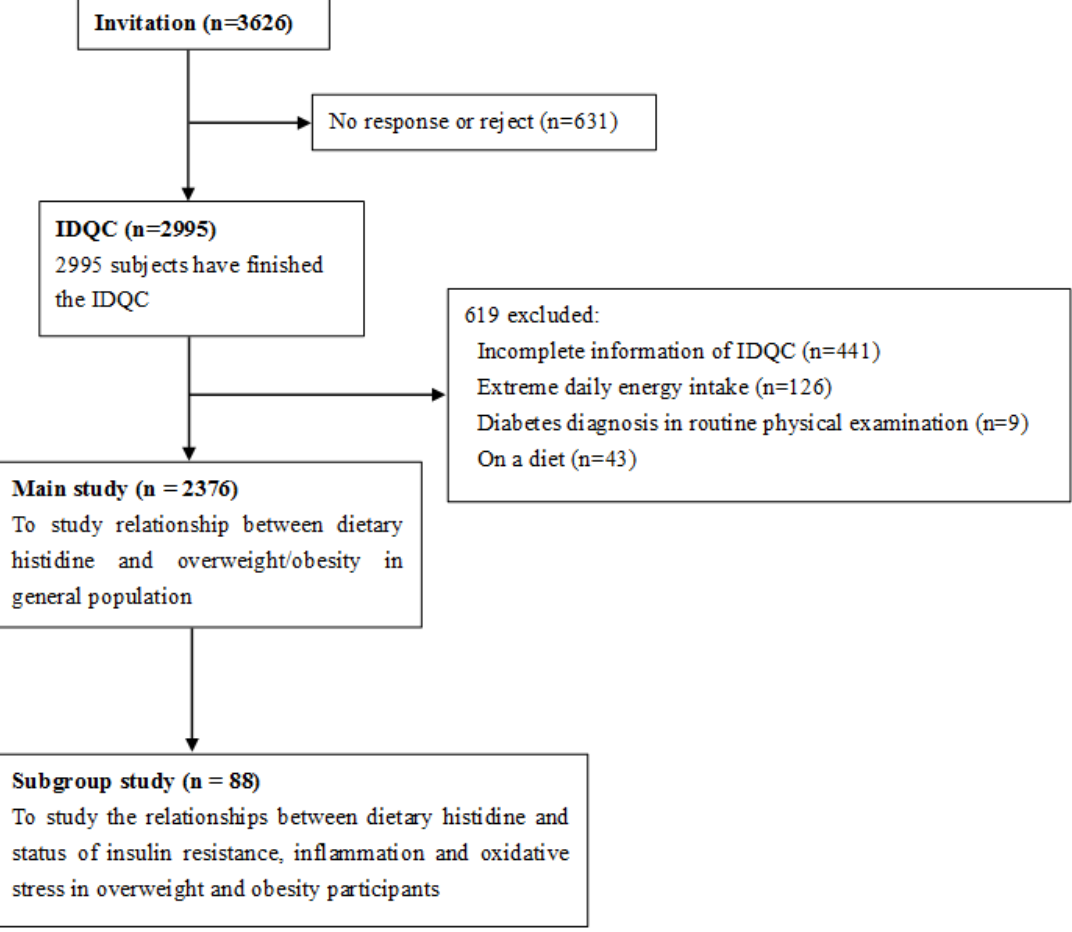
Figure 1. Flow of the study population.